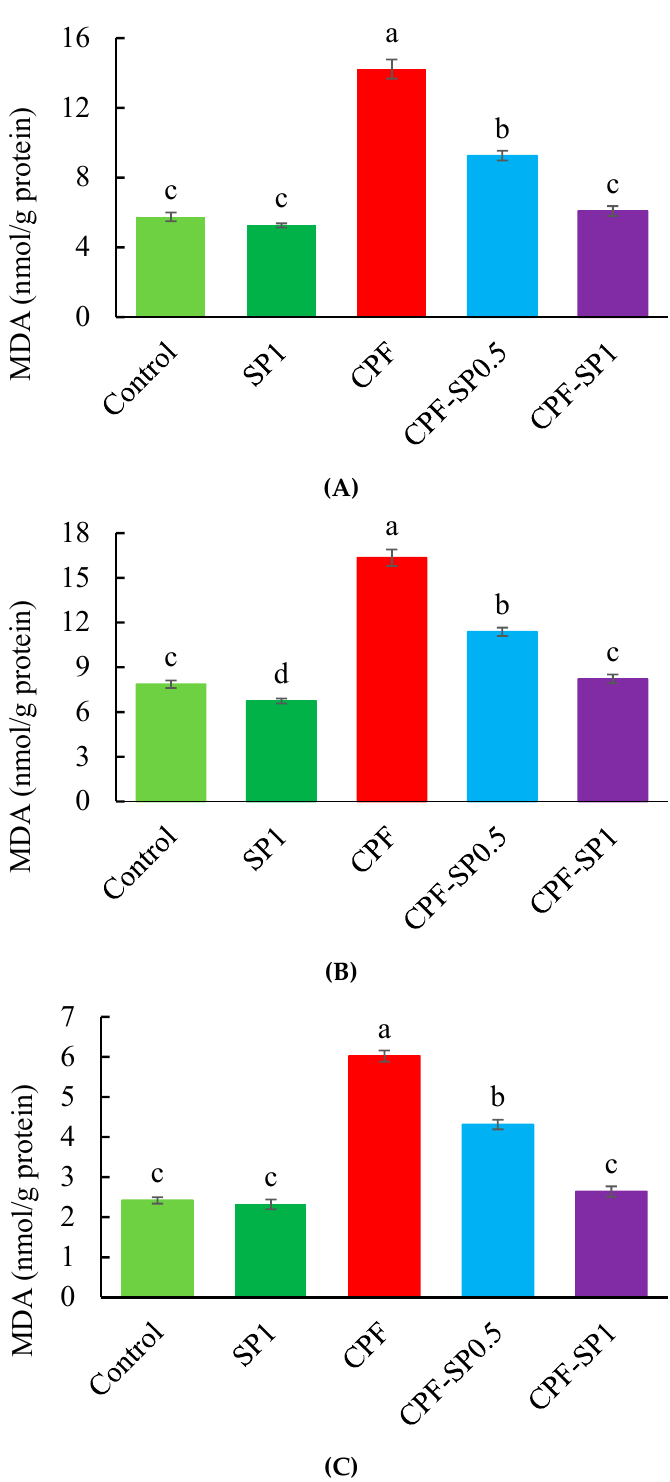
Figure 1. ( A ) Liver, ( B ) kidney, and ( C ) gill malondialdehyde (MDA) levels in the treated groups (nmol/g protein). Data are expressed as means ± SE ( n = 8). Bars with different letters are significantly different ( p ≤ 0.05).